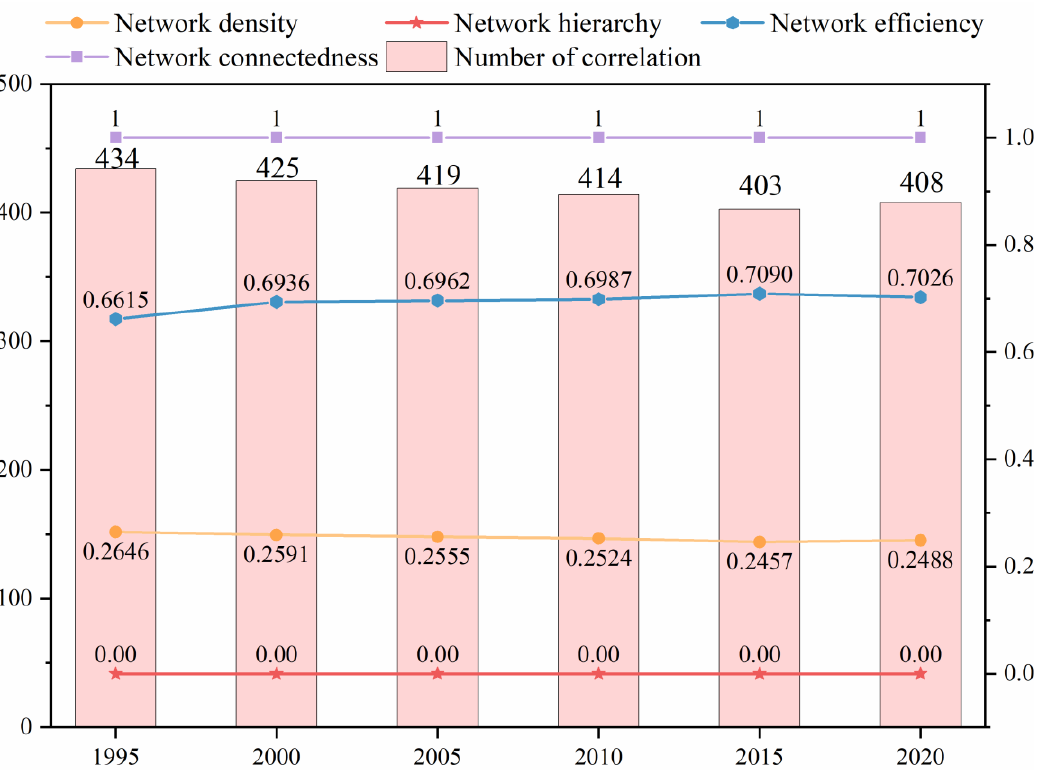
Figure 3. The overall network characteristics in 1995, 2000, 2005, 2010, 2015 and 2020.